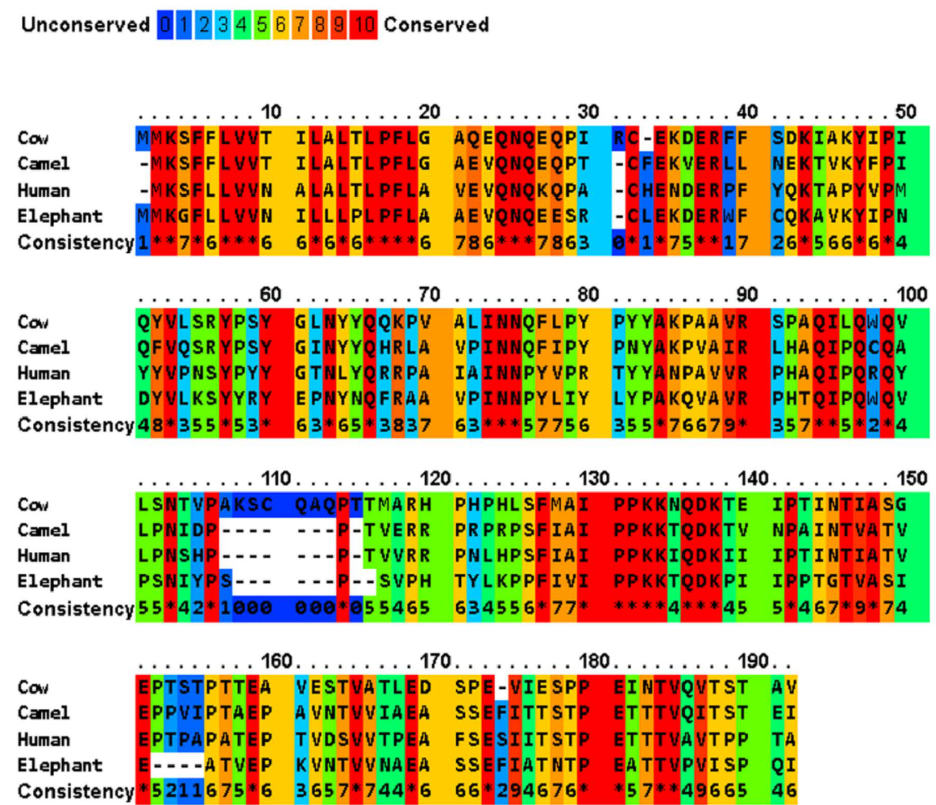
Figure 2. Multiple sequence alignment of cow milk caseins ( α S1- variant B, α S2- variant A, β -variant A1, and κ -variant A) and those of the major camel, human, and elephant caseins, and indication of conserved and unconserved amino acid residues. The amino acid sequences are retrieved from UniProt/NCBI database, and the comparison of protein sequences was performed using PRALINE server (https://www.ibi.vu.nl/programs/pralinewww/, accessed on 13 June 2022) to localize the conserved sequence segments. As the selected sequences may show homoplasy, a low E-value inclusion threshold of 0.001 is used to build the alignment through 10 iterative position specific PSI-BLAST iterations. Amino acid residues: alanine (A), asparagine (N), aspartic acid (D), cysteine